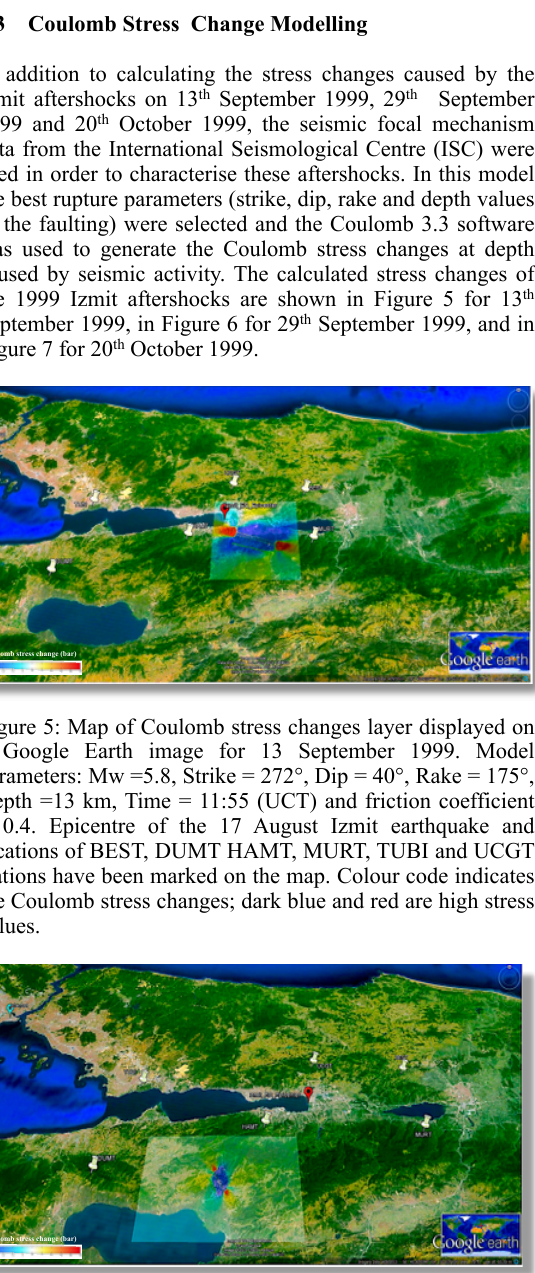
Figure 6: Map of Coulomb stress changes layer displayed on a Google Earth image for 29 September 1999. Model parameters: M w =5.2, Strike = 331°, Dip = 84°, Rake = -43°, Depth = 15km, Time = 00:13 (UCT) and friction coefficient = 0.4. Epicentre of the 17 August Izmit earthquake and locations of the BEST, DUMT HAMT, MURT, TUBI and UCGT CGPS stations have been marked on the map. Colour code indicates the Coulomb stress changes; dark blue and red are high stress values.